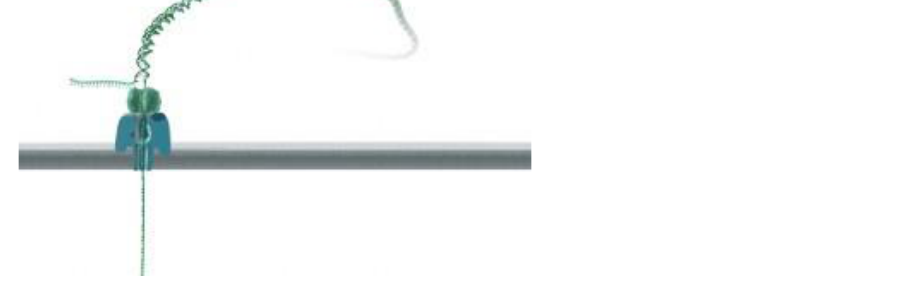
Figure 6. Fast track: nanopore sequencing identifies individual bases as a strand of DNA is passed through a pore. Reprinted with permission from ref. [50]. Copyright 2012 Nature News